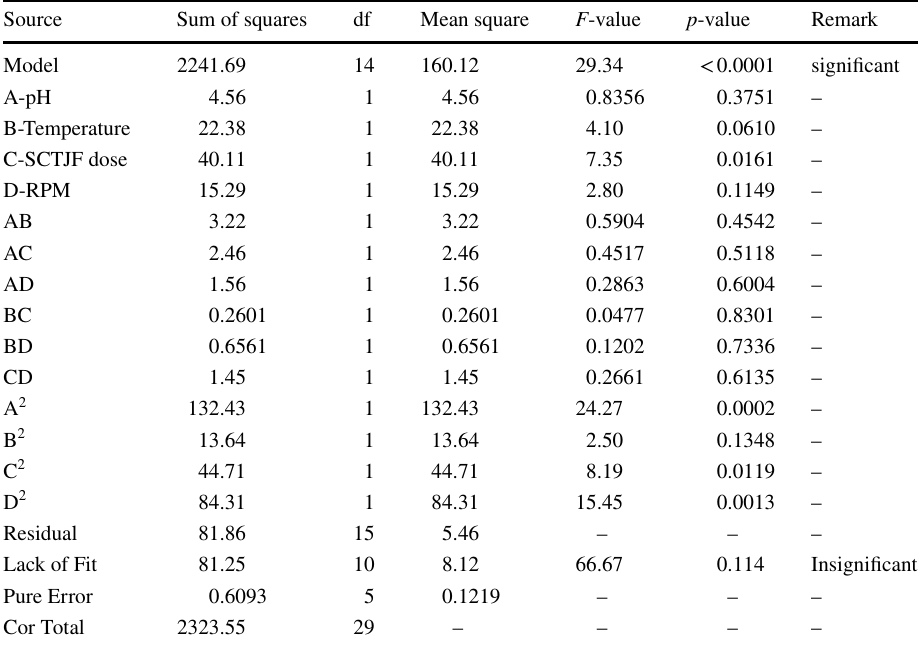
Table 7 The ANOVA results for Q max